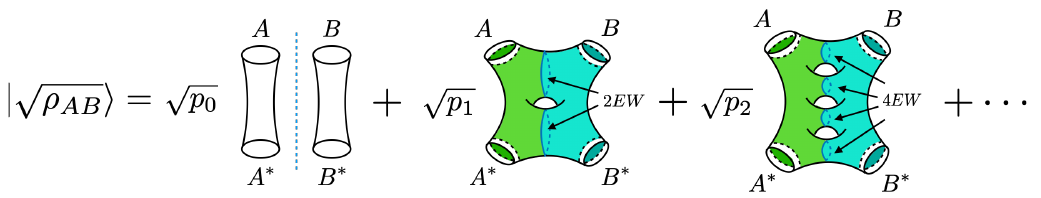
|√ Figure 3 . The canonical purification ρ AB i consists of a superposition of a one parameter family of geometries labelled by k . They are obtained by gluing together 2 k copies of the shaded portion (see figure 2) of the connected entanglement wedge of AB in the four boundary wormhole. The k -th geometry has 2 k copies of the entanglement wedge cross section labelled EW